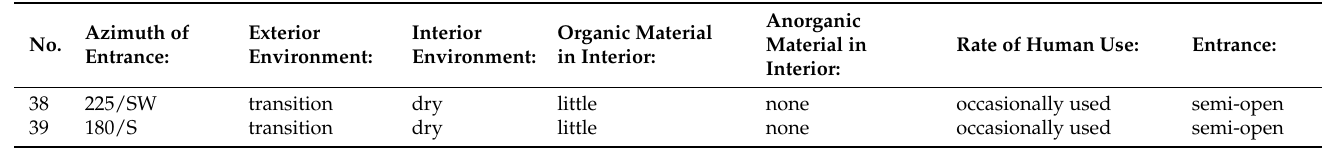
Table A5. Table of SA-CEFs study objects with data that were obtained by field survey (2014-2021). The numbering of the individual SA-CEFs corresponds to the data in Table 1—part